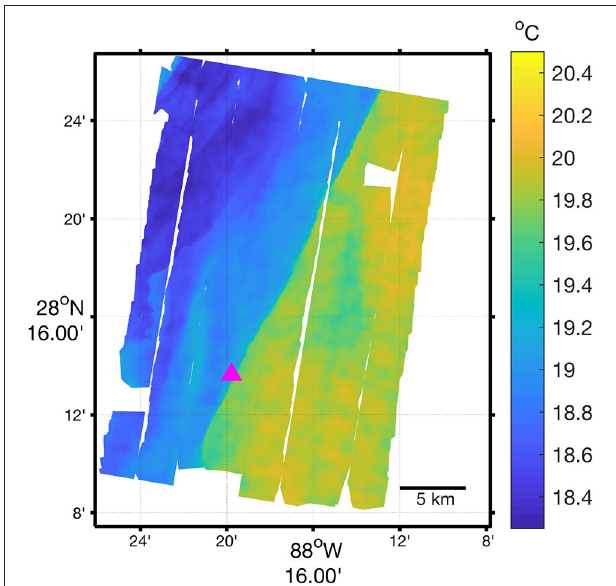
FIGURE 5 | An aerial SST mosaic (section 2.3.5) of the area targeted during the STARSS experiment (magenta triangle) shows a sharp front that extends from the northeast to the southwest, with colder water on the west and warmer water on the east side of the front.